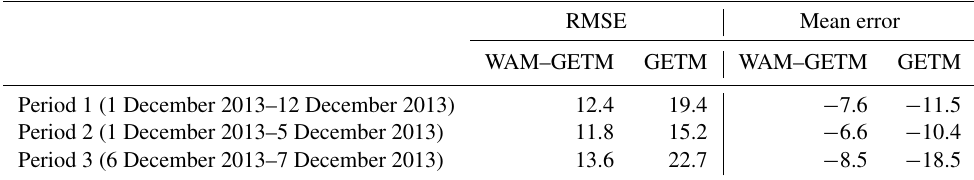
Table 1. Statistics of the validation. In addition to mean and standard deviation, the coefficients of a linear regression are given. Elbe Hoernum Tief Hs (m) tm1 (s) Hs (m) tm1 (s) Mean measurements 1.10 WAM WAM–GETM WAM WAM–GETM WAM WAM WAM–GETM Bias 0.004 − 0.025 0.245 0.174 SD 0.164 0.171 Slope